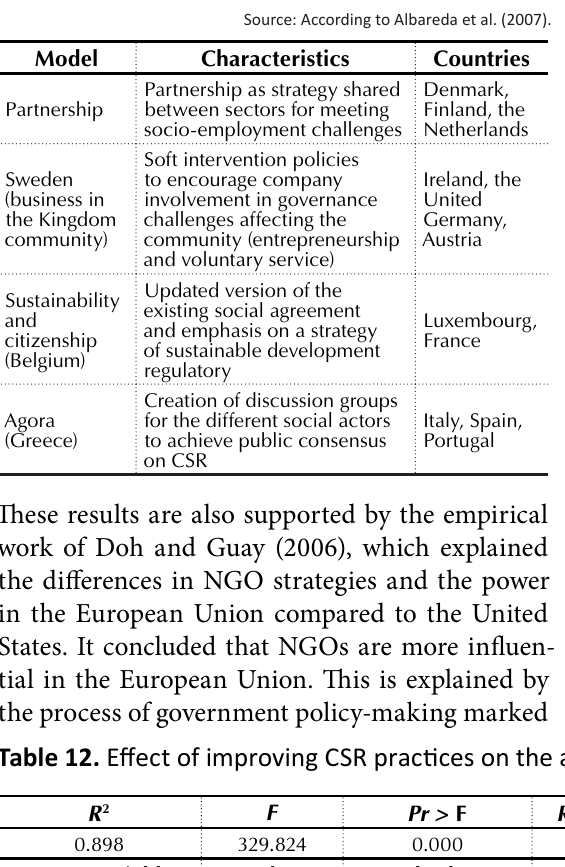
Table 11. Models of policies improving CSR practices in 15 EU countries